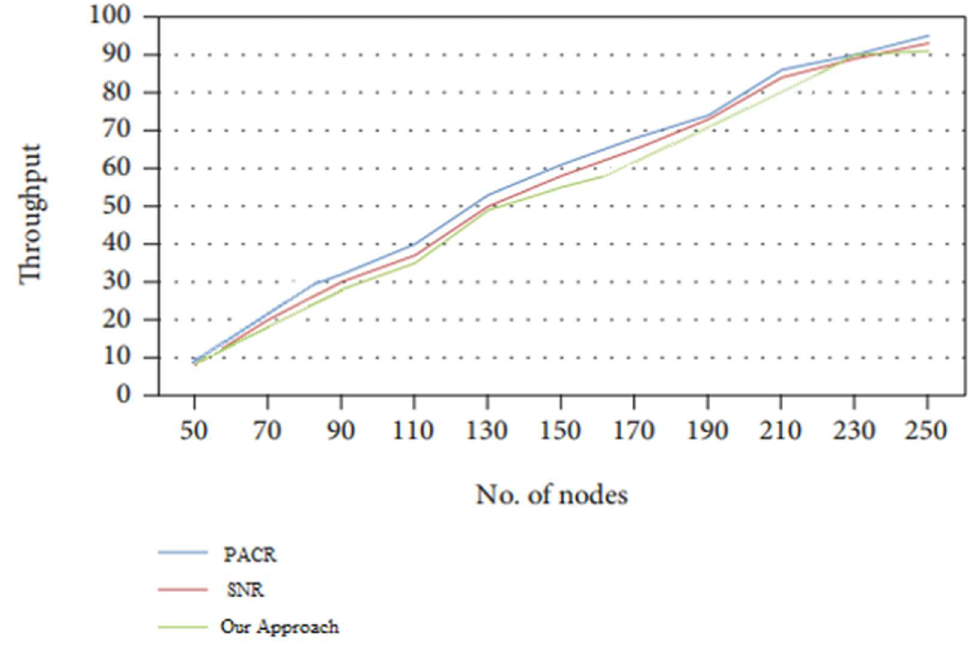
Figure 4. Number of nodes vs. throughput.